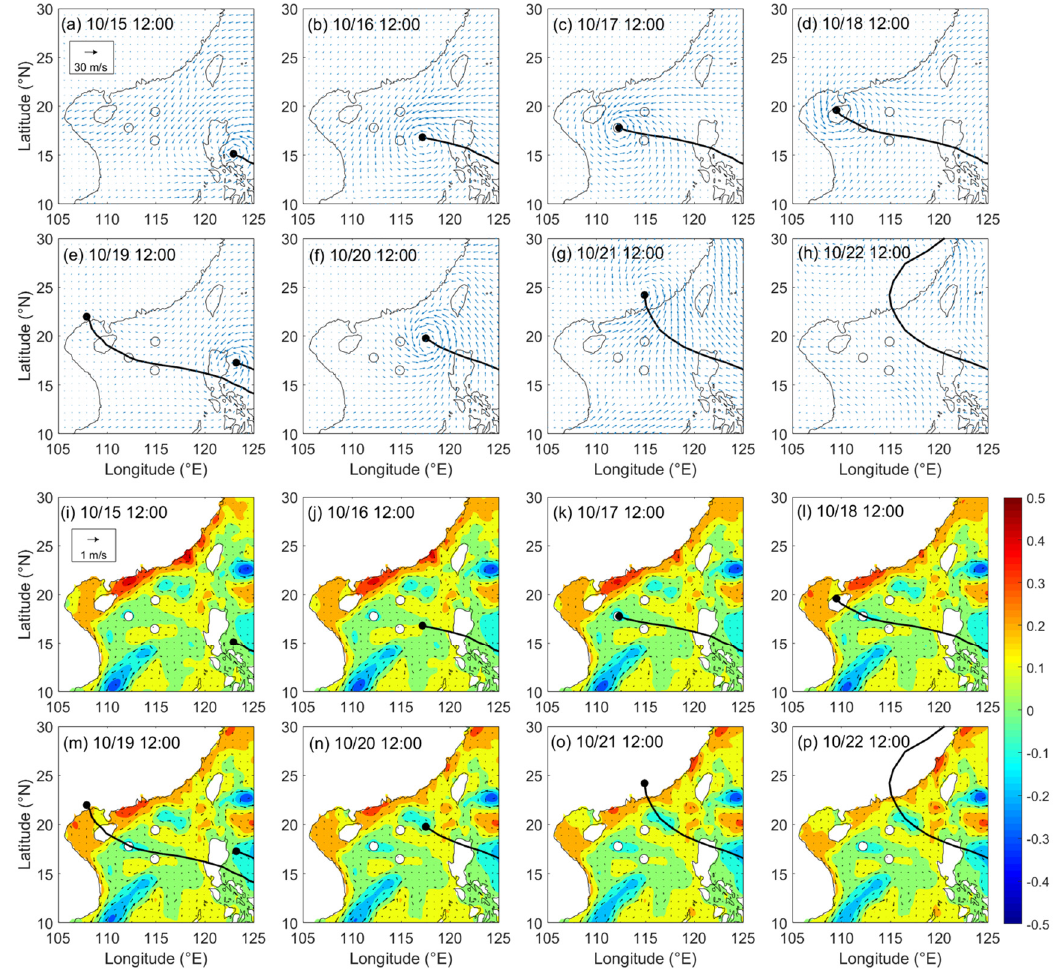
Figure 4. ( a – h ) Wind data obtained by CCMP at 12:00 UTC between October 15 and 22 and ( i – p ) CMEMS sea surface height (color) and geostrophic current (vector) anomalies. CCMP: cross-calibrated multi-platform. CMEMS: Copernicus Marine and Environment Monitoring